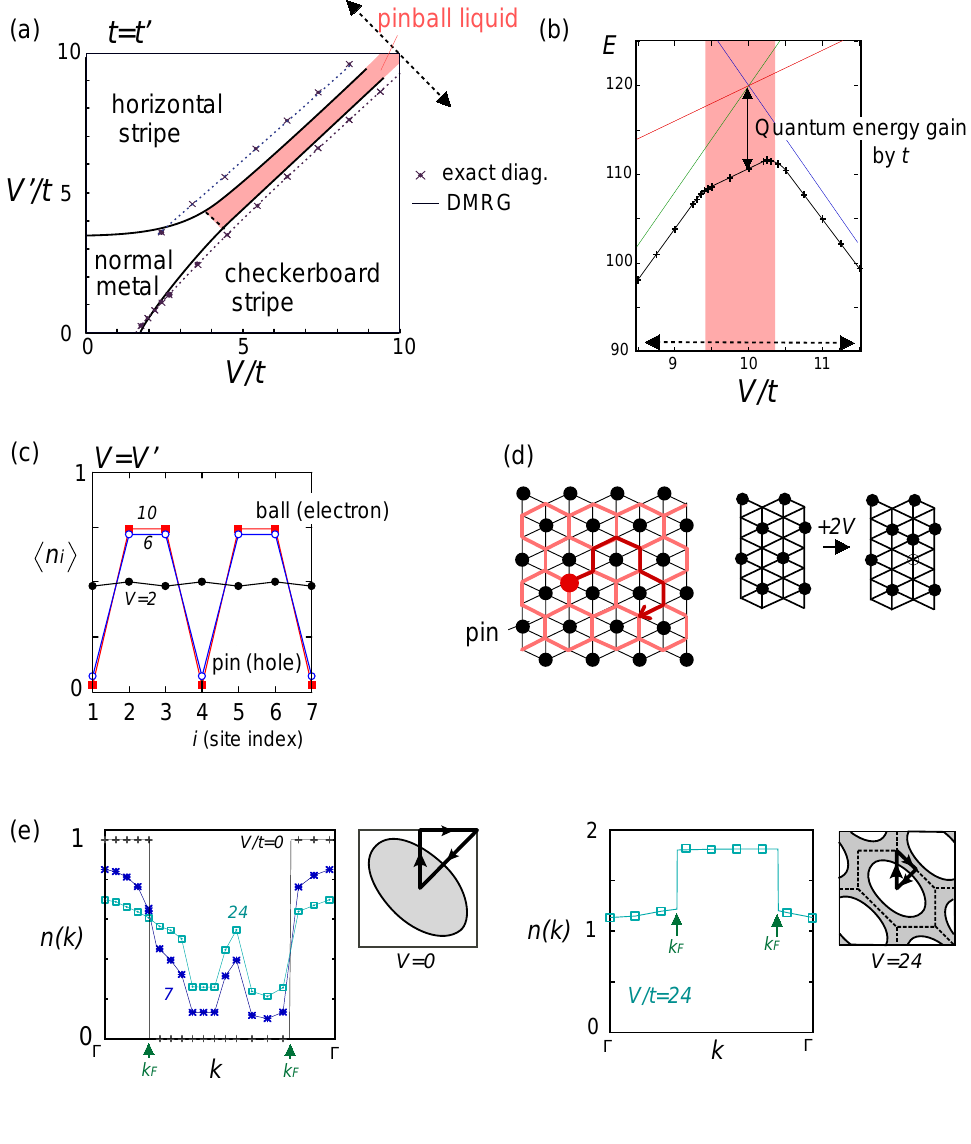
Figure 9. Numerical results of the t - V model on the anisotropic triangular lattice. ( a ) Phase diagram at t = t (cid:48) by the DMRG with N = 8 × 6 [27]; ( b ) Energy along the fixed value of V + V (cid:48) obtained by the exact diagonalization with N = 6 × 4 [28], showing the reconstruction of levels from those of the classical limit (Figure 6). The kink of the energy line gives the phase boundary shown in ( a ) [25]; ( c ) Charge distribution function (cid:104) n along one bond direction by the DMRG, from [27]; ( d ) Sketch of a pinball liquid state (left) and the process of moving pins (right panel); ( e ) Momentum distribution function n ( k ) of the full Brillouin zone (left panel), and of the folded (1/3) Brillouin zone (right panel) by the VMC in [29], together with the schematic Fermi surfaces. The axis k is taken along the arrow of the Brillouin zone in the inset. At V/t = 24 , n ( k ) is shown for full and 1/3-folded Brillouin zones, and the latter displays a reconstruction of the Fermi surface, with a Fermi liquid type of